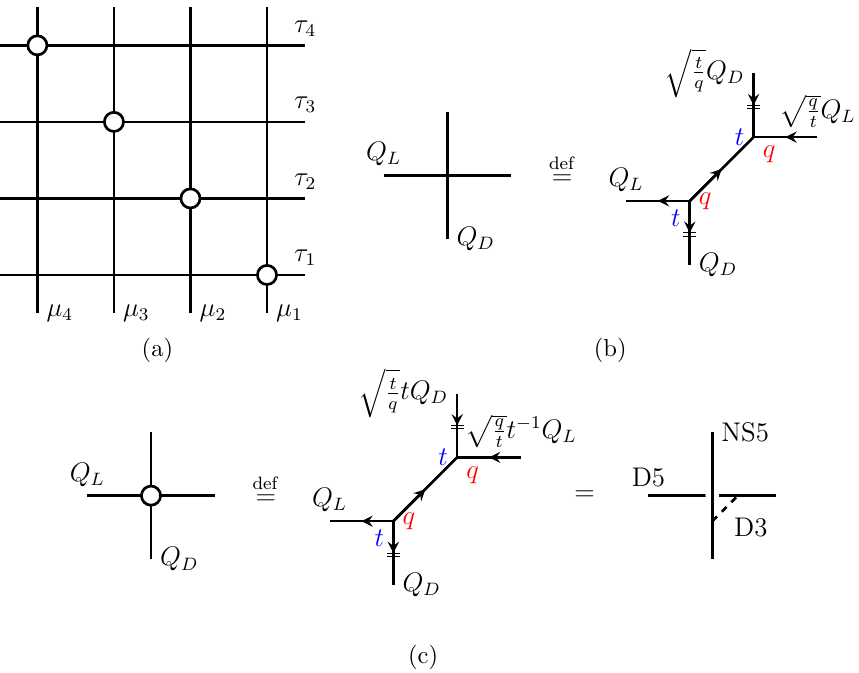
Figure 8 . (a) The toric diagram S for the higgsed gauge theory, i.e. for parameters tuned as in eq. (3.8). We have rotated the picture compared to (cid:12)gure 6 by (cid:25) to aid explicit re(cid:12)ned topological 2 string computations. b) The \empty crossing" denotes the fully degenerate re(cid:12)ned conifold ampli- tude. (c) The \higgsed crossing" denote re(cid:12)ned conifold amplitude corresponding to the